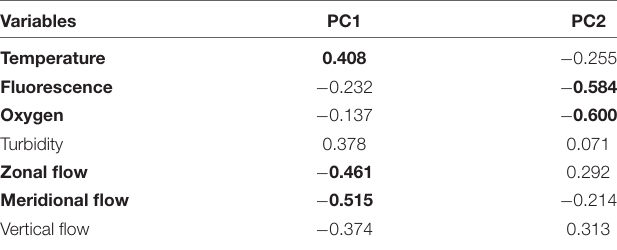
TABLE 5 | Results of the principal component analysis